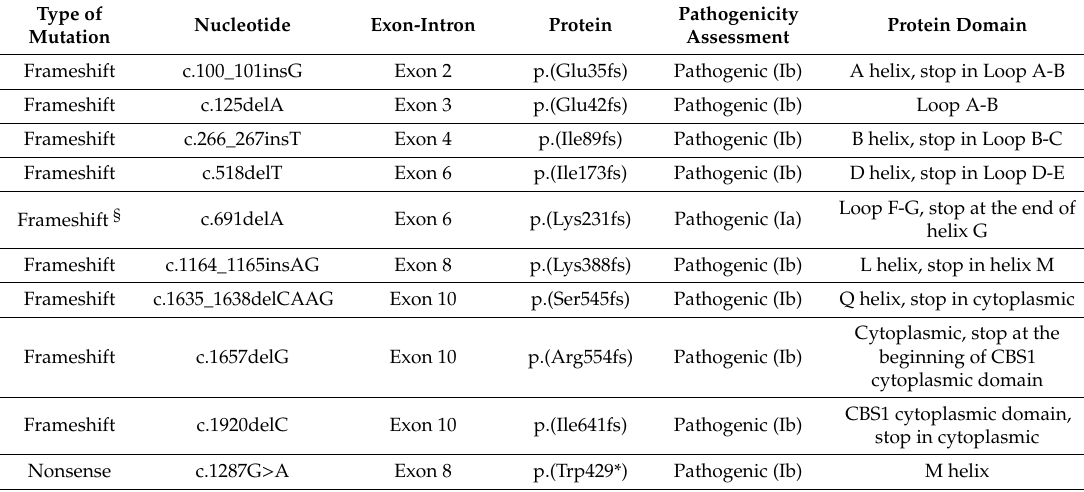
Figure 2. Percentages of mutations of CLCN5 gene by type.